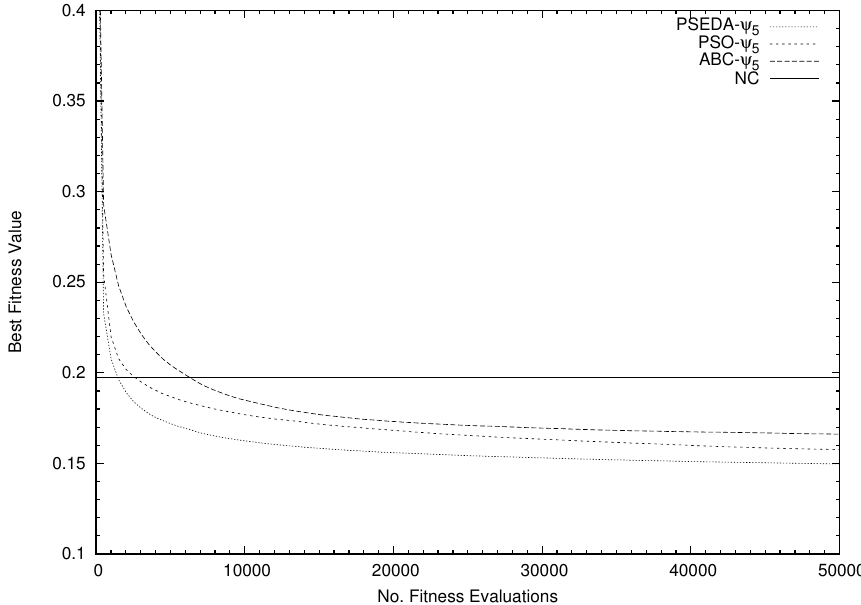
Figure 2. Average fitness trends for the SI classifiers (equipped with ψ 5 ) and the NC